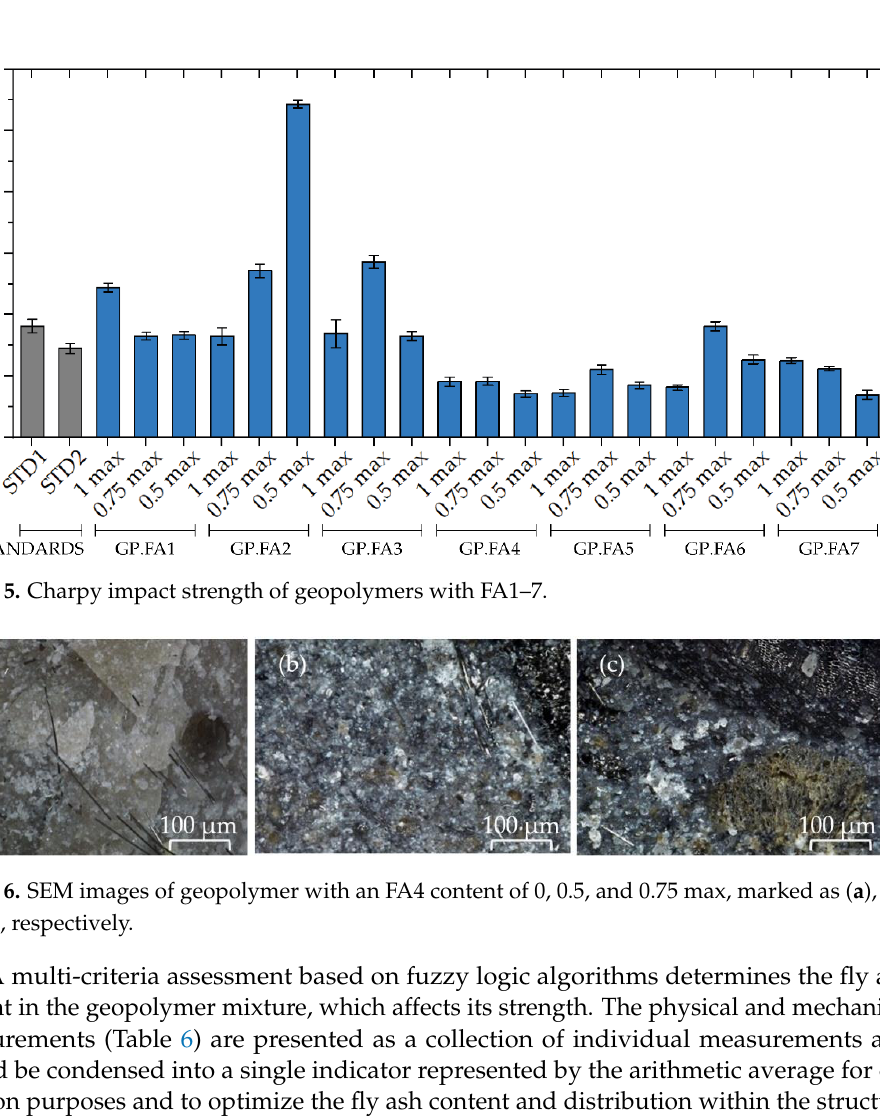
Table 6. Physical parameters for the optimization of fly ash-based geopolymer compositions.